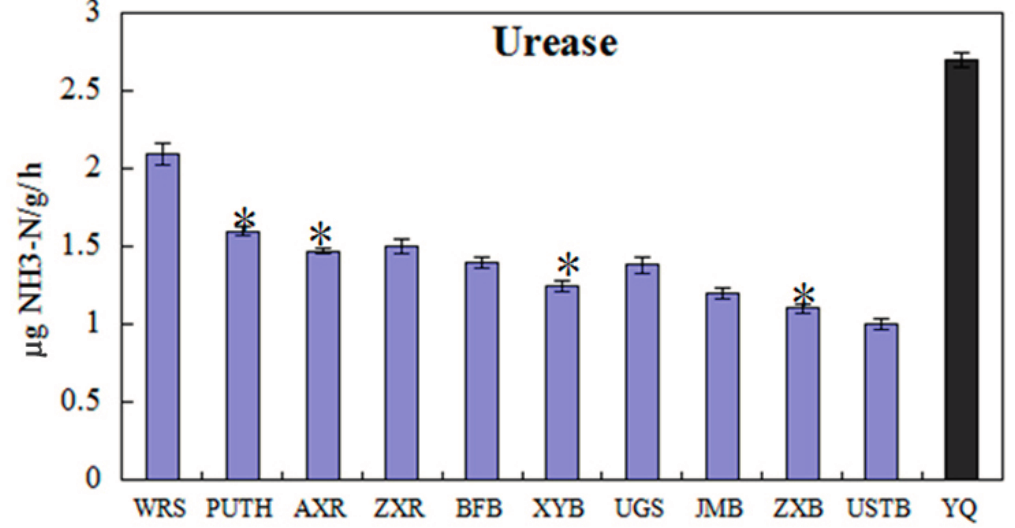
Figure 2. The dehydrogenase, catalase and urease activities in the study samples (light dark) and control sample (dark). Error bars are S.E; * indicates variance yields.